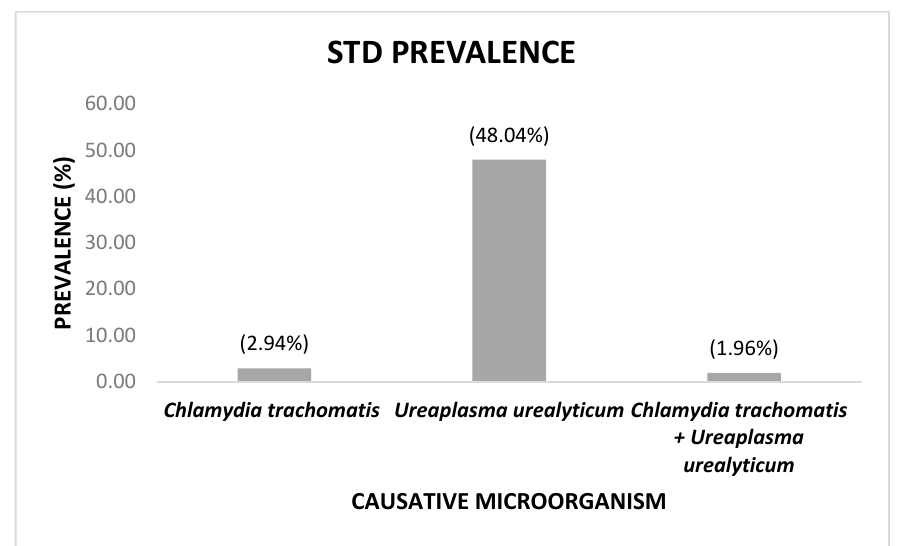
Figure 1. Prevalence of sexually transmitted diseases according to the causative microorganism. Co-infections are included. Table 1. The association of sociodemographic variables with positive or negative results obtained for sexually transmitted diseases (STDs) caused by Chlamydia trachomatis , Neisseria gonorrhoeae , and Ureaplasma urealyticum